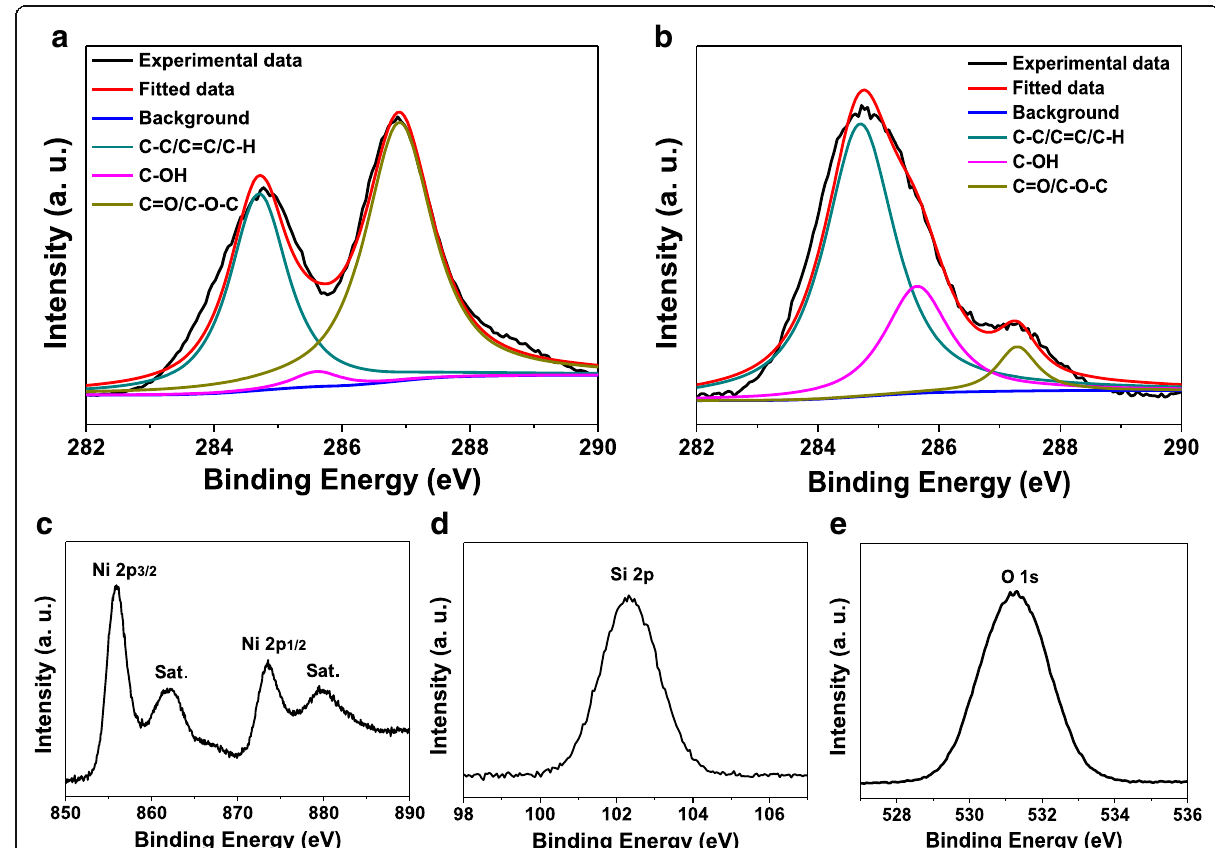
Fig. 5 a High-resolution XPS of C 1s of tiny GO sheets. b – e High-resolution XPS of Ni 3 Si 2 O 5 (OH) 4 /RGO hollow microspheres, showing the C 1s, Ni 2p, Si 2p, and O 1s regions,